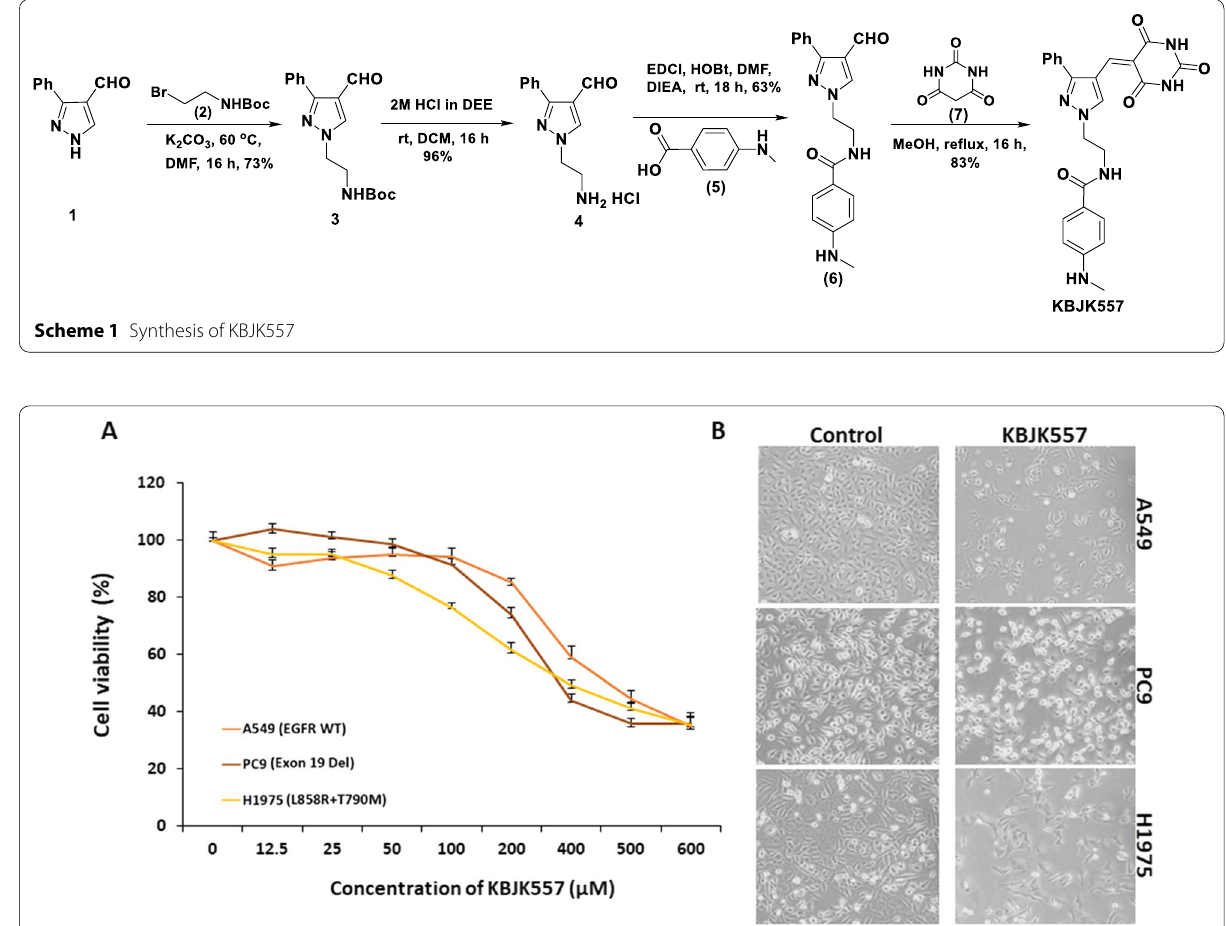
Fig. 1 Cytotoxic effects of KBJK557 on the A549, PC9, and H1975 cells. A Cells were treated with various concentration of KBJK557 for 24 h. Cell viability was evaluated by MTT assay. B Change of morphology of non‑small cell cancer cells. Cells were treated with KBJK557 for 24 h. Cells were photographed using the phase‑contrast microscope ( 200 ×